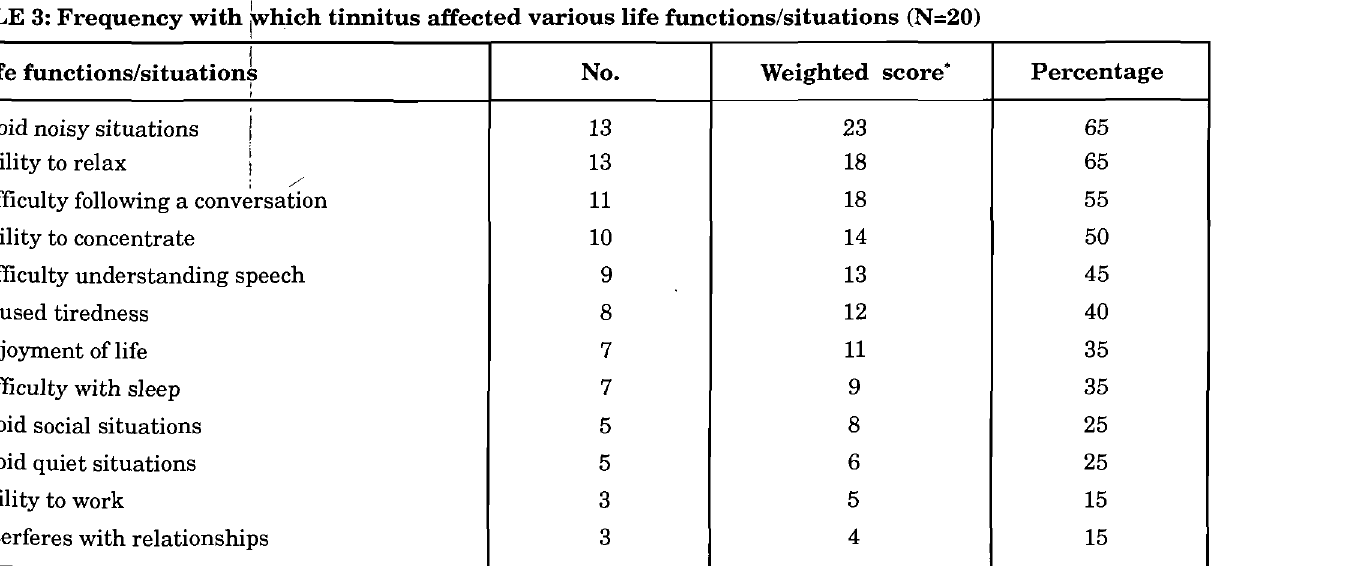
~hiCh TABLE 3: Frequency with tinnitus affected various life functions/situations (N=20) Life functions/situation~ No. Weighted score